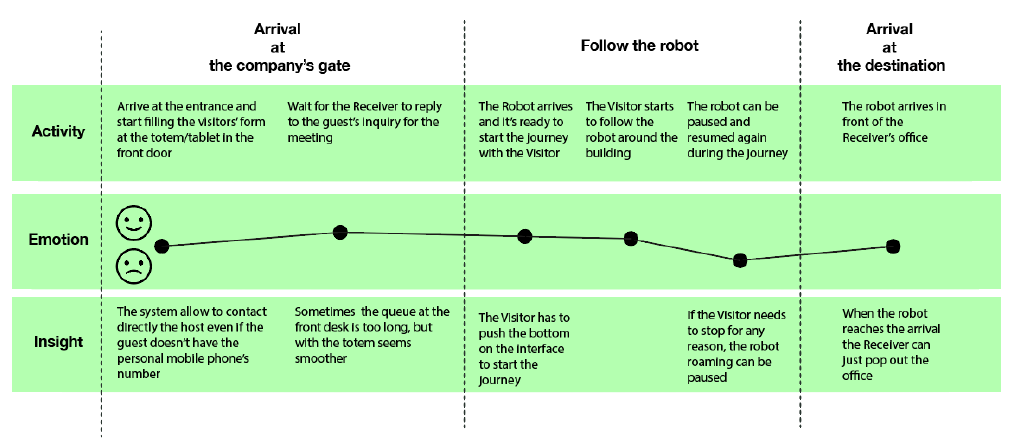
Figure 1. Example of the customer experience in the building, recreated after the findings of the workshop performed with the employees in the company’s building and the robot’s